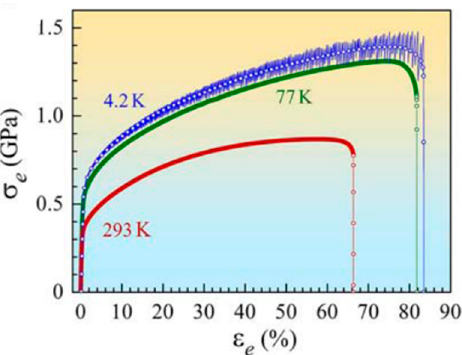
Figure 3. Tensile engineering stress–0strain curves of the CoCrNi MEA at 4.2 K, 77 K and 293 K. Reprinted with permission from Ref. [23]. Copyright 2019, Elsevier.